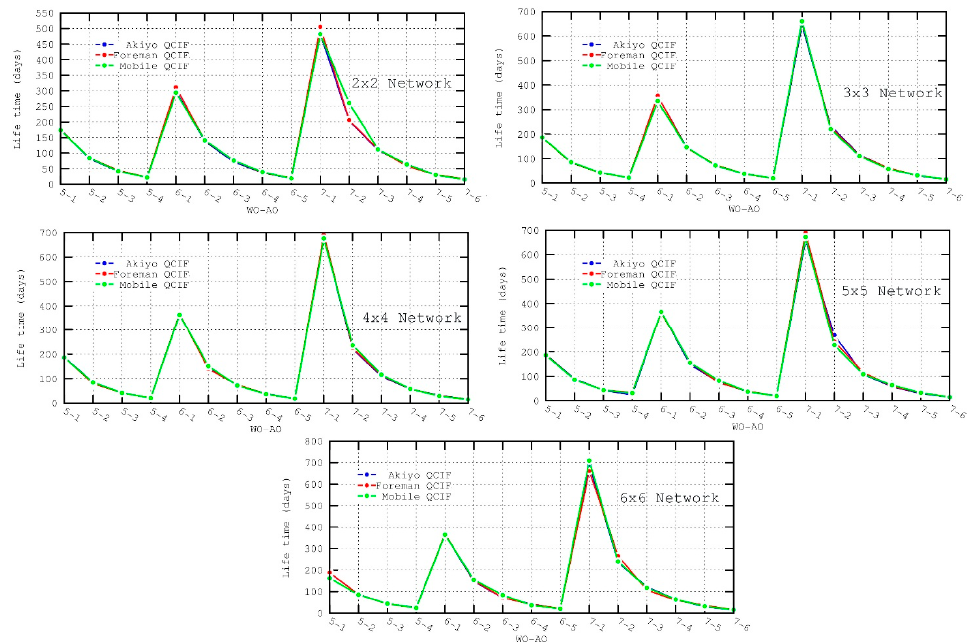
Figure 15. Lifetime metric for the different scenarios.